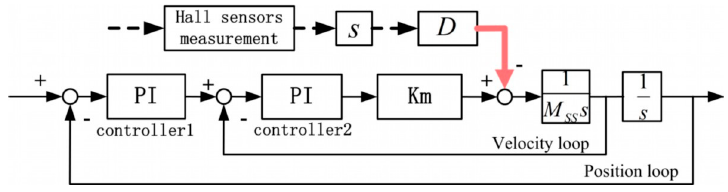
Figure 14. Force feedforward to compensate VDDFs.